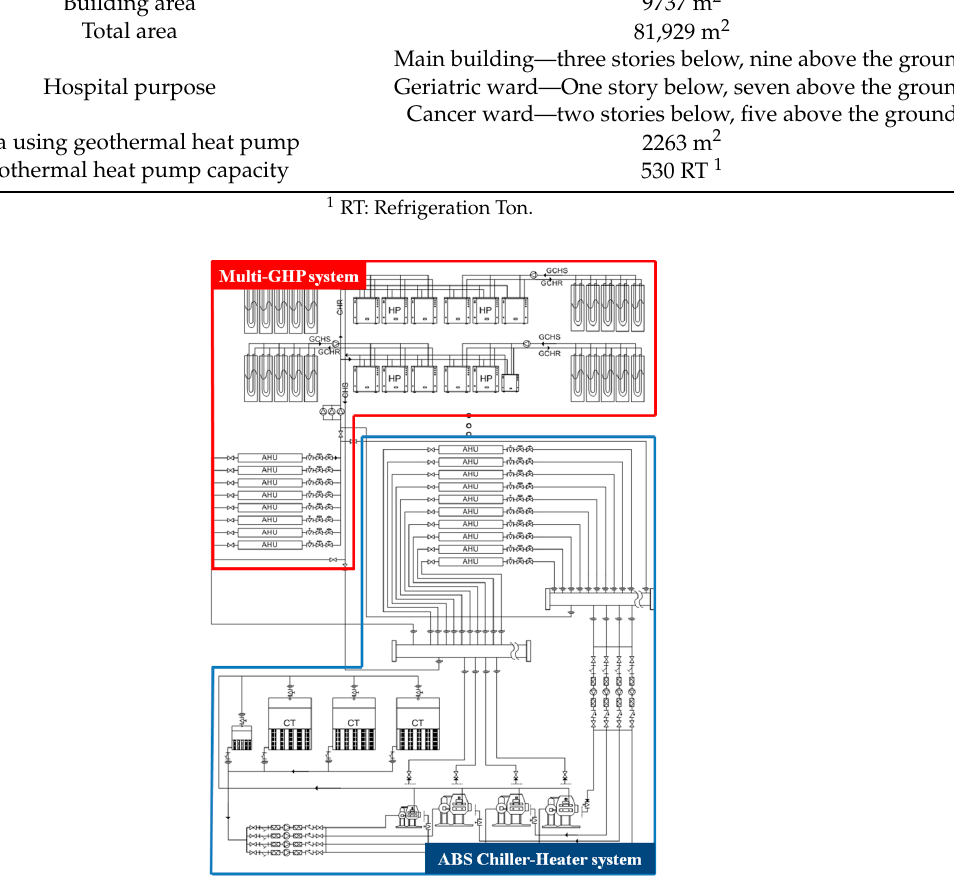
Figure 1. System diagram of the hybrid operation method for the geothermal heat pump system and absorption chiller ‐